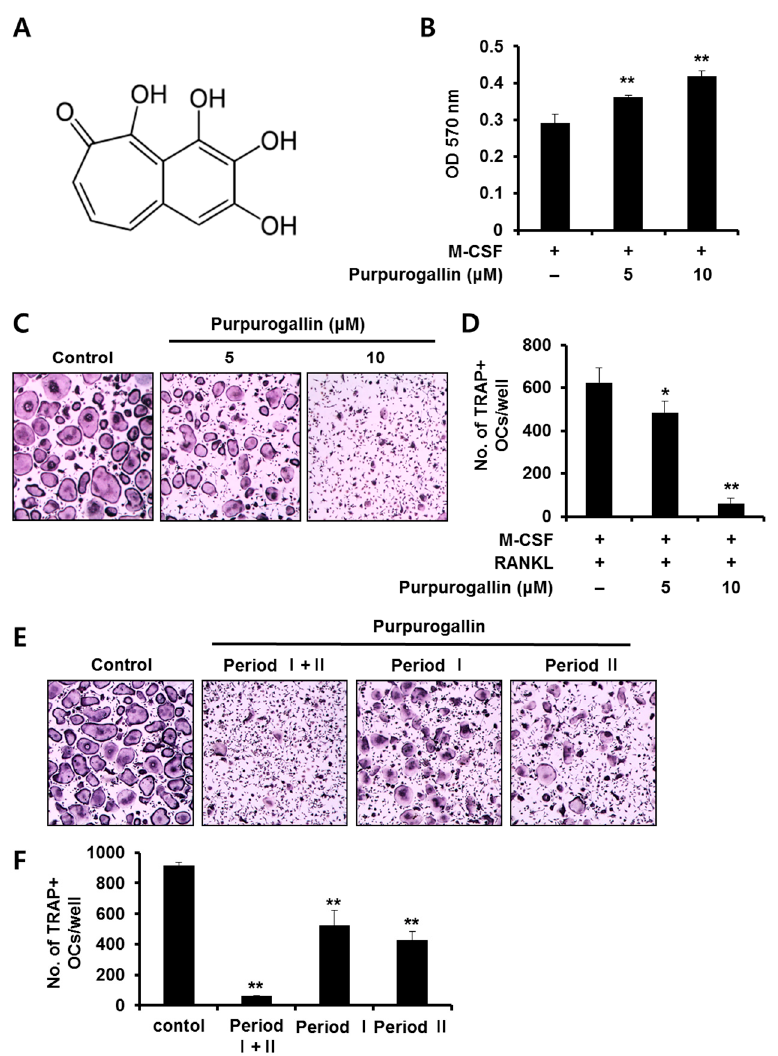
Figure 1. Purpurogallin inhibits receptor activator of nuclear factor kappa-B ligand (RANKL)-induced osteoclast differentiation. ( A ) Chemical structure of purpurogallin; ( B ) BMMs were incubated with M-CSF (10 ng/mL) in the presence of 0, 5, or 10 μ M purpurogallin for 3 days. Cell viability was assessed using the MTT assay. ** p < 0.01 versus vehicle-treated control; ( C ) BMMs were incubated with M-CSF (10 ng/mL) and RANKL (20 ng/mL) in the presence of 0, 5, or 10 μ M purpurogallin for 4 days. The cells were stained for TRAP. Magnification 50×; ( D ) TRAP-positive cells with more than three nuclei were scored. * p < 0.05, ** p < 0.01 versus vehicle-treated control; ( E ) BMMs were cultured with M-CSF (10 ng/mL) and RANKL (20 ng/mL) in the presence or absence of purpurogallin (10 μ M). Purpurogallin was added from day 0 to day 4 (period I + II), from day 0 to day 2 (period I), or from day 2 to day 4 (period II). Osteoclast formation was assessed by TRAP staining. Magnification 50×; ( F ) TRAP-positive multinucleated cells with ≥ 3 nuclei were counted. ** p < 0.01 versus vehicle-treated control.